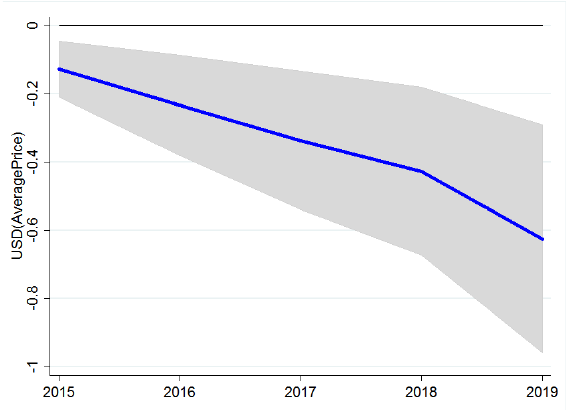
Figure 3. Cumulative Response of AveragePrice to NGER.